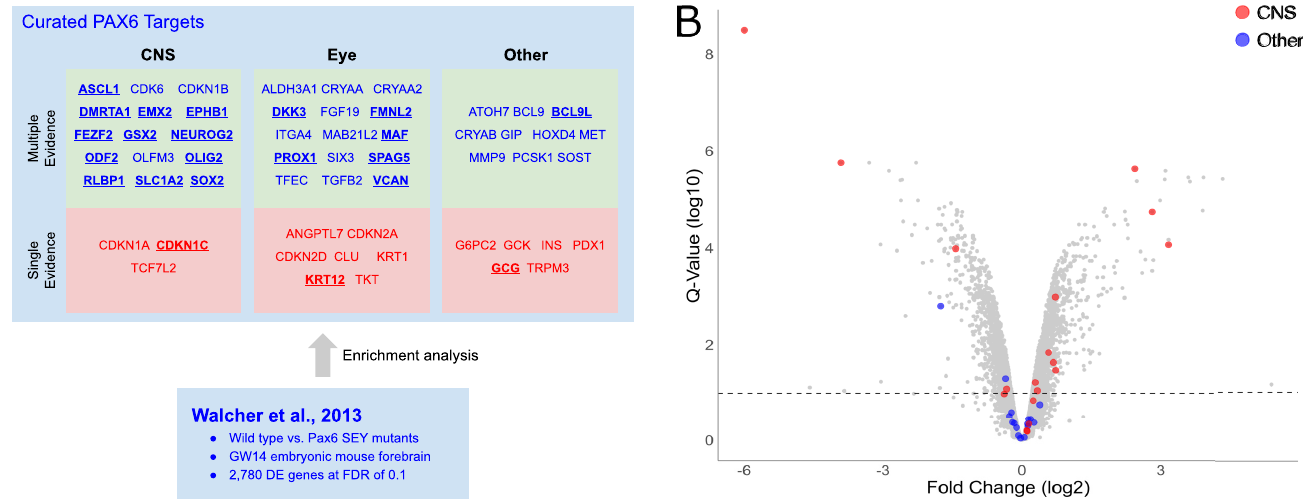
Fig 5. Comparison with a high-throughput Pax6 perturbation screen. (A) Summarized result of the comparative analysis. Curated PAX6/Pax6 targets are organized by tissue and number of types of experimental evidence. Genes differentially expressed at FDR of 0.1 are bolded and underlined. (B) Volcano plot of differential expressions between wildtype and Pax6-Sey mouse embryonic forebrains. Curated PAX6/pax6 targets are highlighted with tissue specificity as depicted in the color legend. Fold change (log 2 ) is displayed in x-axis. Multiple test corrected q-values (Benjamini-Hochberg Procedure) are plotted on the y-axis on a log10 scale. Dotted line indicates 0.1 FDR for reference. Curated CNS targets are highly overrepresented in the differentially expression profile (p-value < 8.5x10 -9 , hypergeometric test) whereas no overrepresentation was detected for the targets in the “Other” category (p-value < 0.47, hypergeometric test).